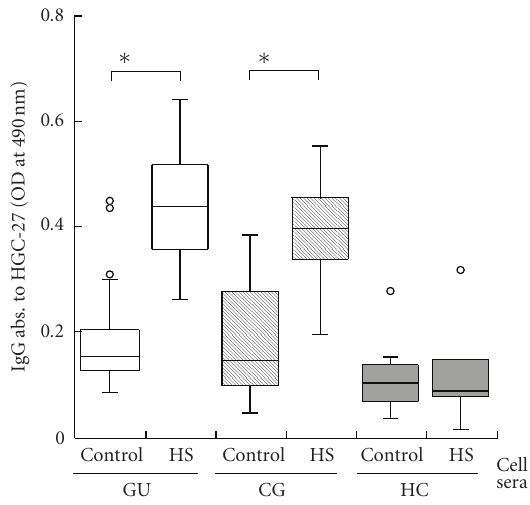
Figure 1: Autoantibody to heat-stressed HGC-27 cells in GU patients . (a) The titers of anti-HGC27 antibodies in patients with H. pylori infection and healthy volunteers are shown. The open column indicates the antibody titer in GU patients, the striped is CG patients, and the solid is HC. The left column displays the titers of anti-nonheat-stressed HGC27 antibody and the right antiheat- stressed HGC27 antibody in each group. The titers of anti-HGC-27 antibody were significantly elevated by heat stress in GU and CG patients ( ∗ P < .